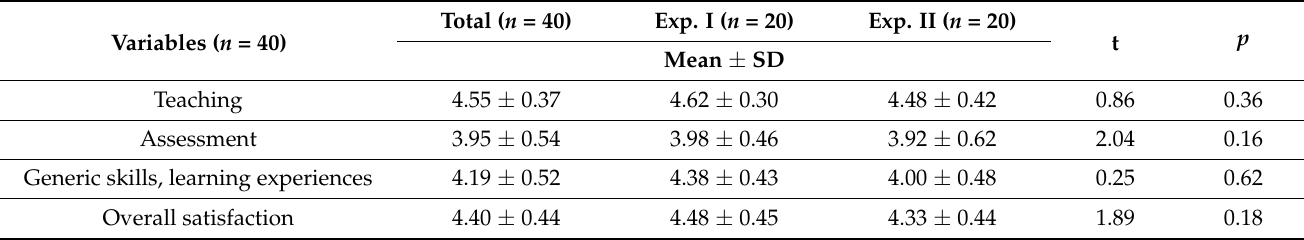
Table 5. Level of student satisfaction (N = 40).